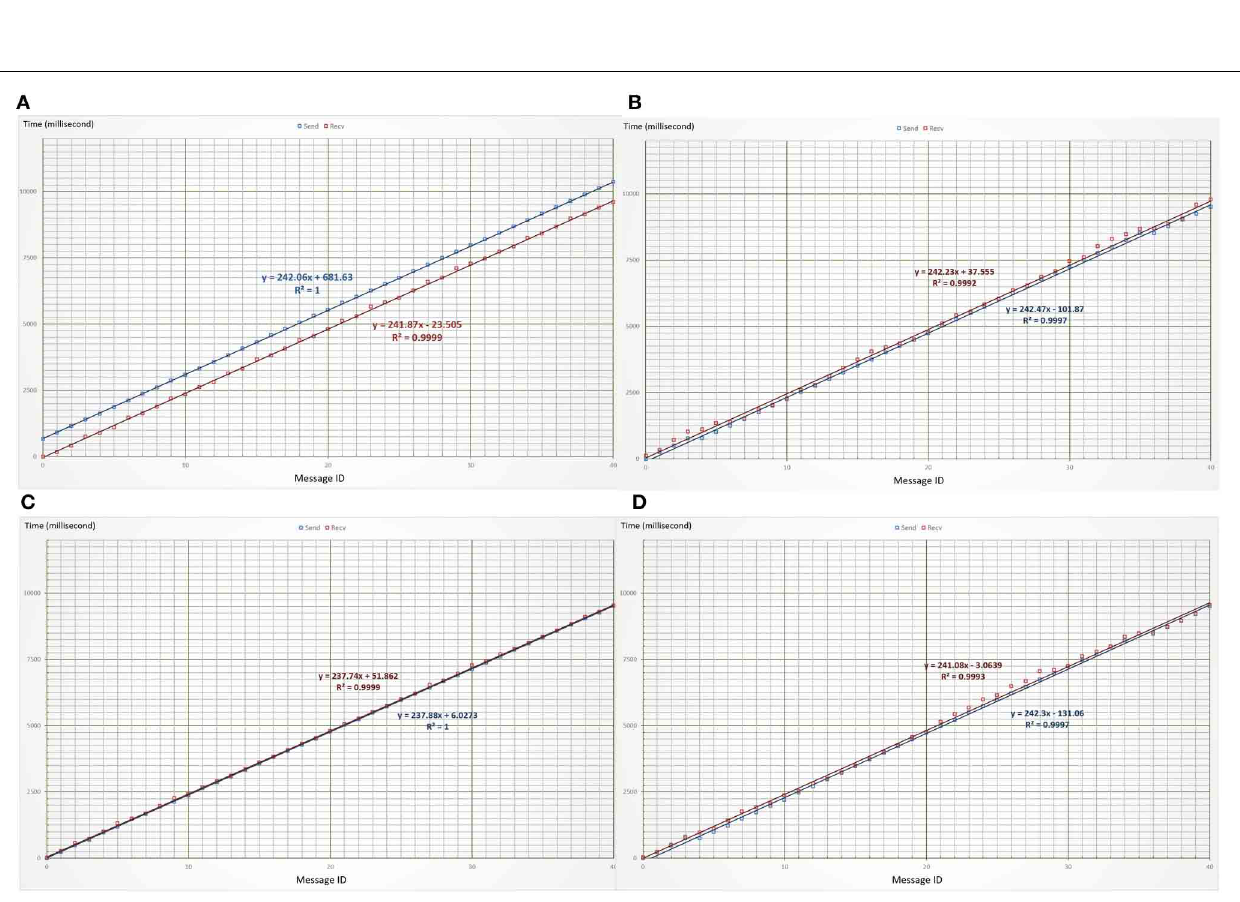
in the same session. The blue lines mark the traces of transmission time while the red lines mark those of reception time. Their slopes give the average transmission and reception intervals of individual